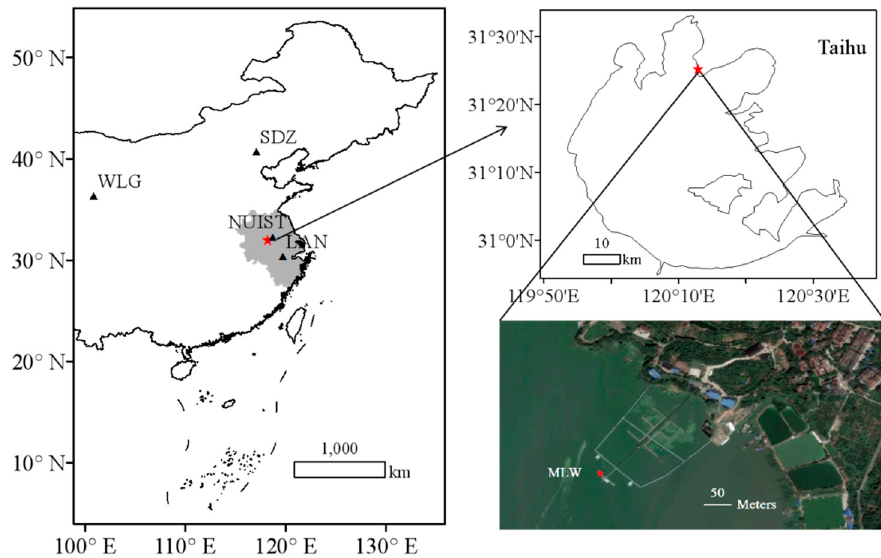
Figure 1. Location of the MLW site (pentagram in red color), Nanjing University of Information Science and Technology (NUIST) and three Chinese WMO/GAW stations, including Lin’an (LAN), Shangdianzi (SDZ) and Waliguang (WLG).